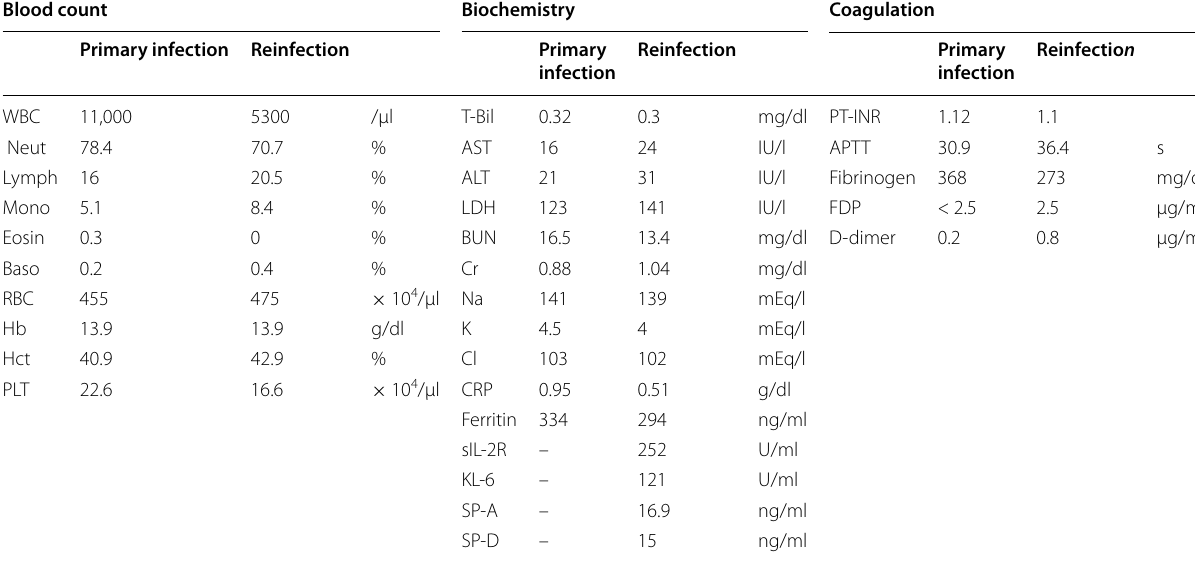
Table 1 Comparison of laboratory findings at diagnosis at the time of primary infection and reinfection Blood